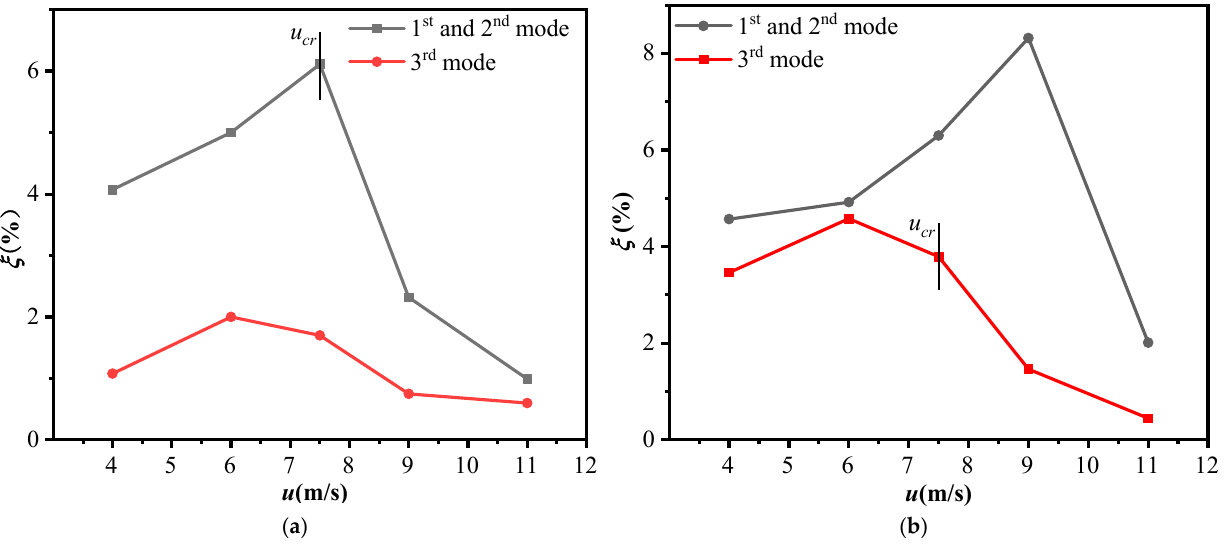
Figure 17. Variation of modal damping ratios with wind speeds: ( a ) the first 3 modal damping ratio of d 1 and ( b ) the first third modal damping ratio of d 2 .